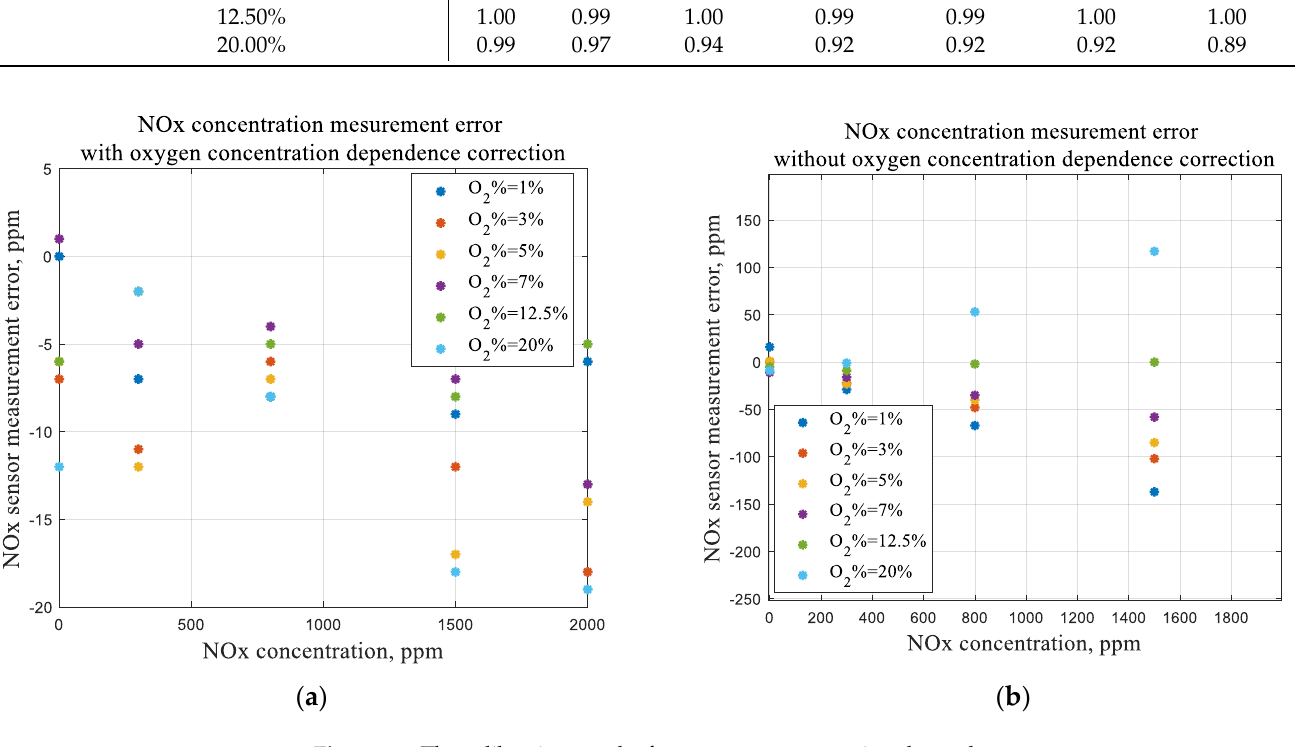
O 2 Concentration